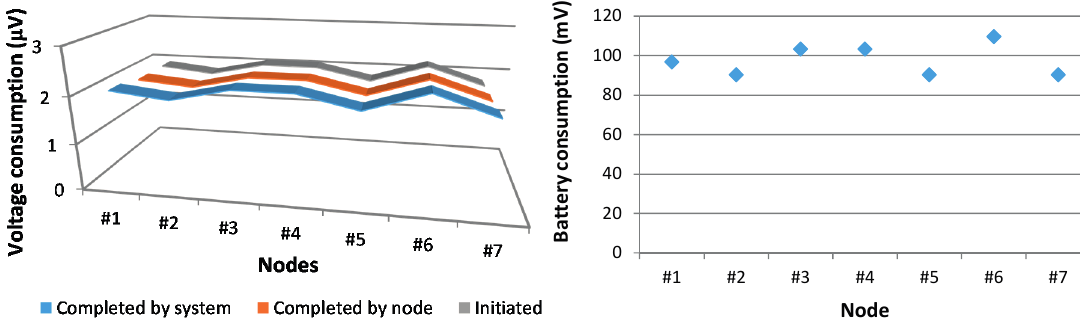
Figure 22. Battery consumption according to the number of iterations initiated, completed by node and completed by the system ( left ), and battery consumption (in millivolts) after 50,000 iterations initiated ( right ).